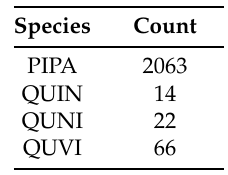
Table 4. JERC-RD species abundance for the four tower plots in